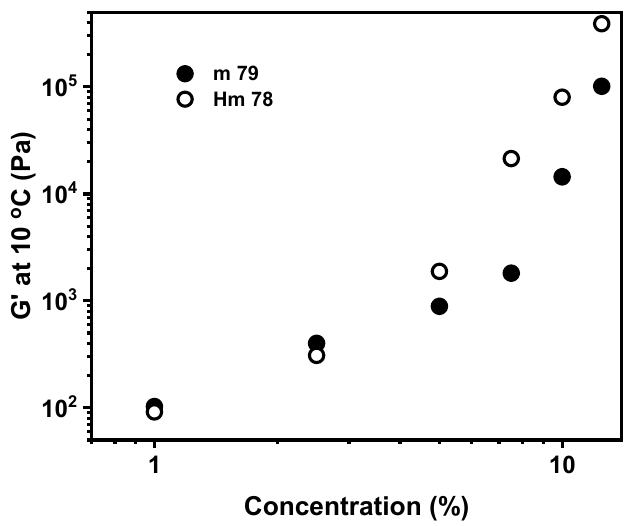
Figure 8. Comparison between G’ of m79 and Hm78 at 10 °C as a function of concentration.